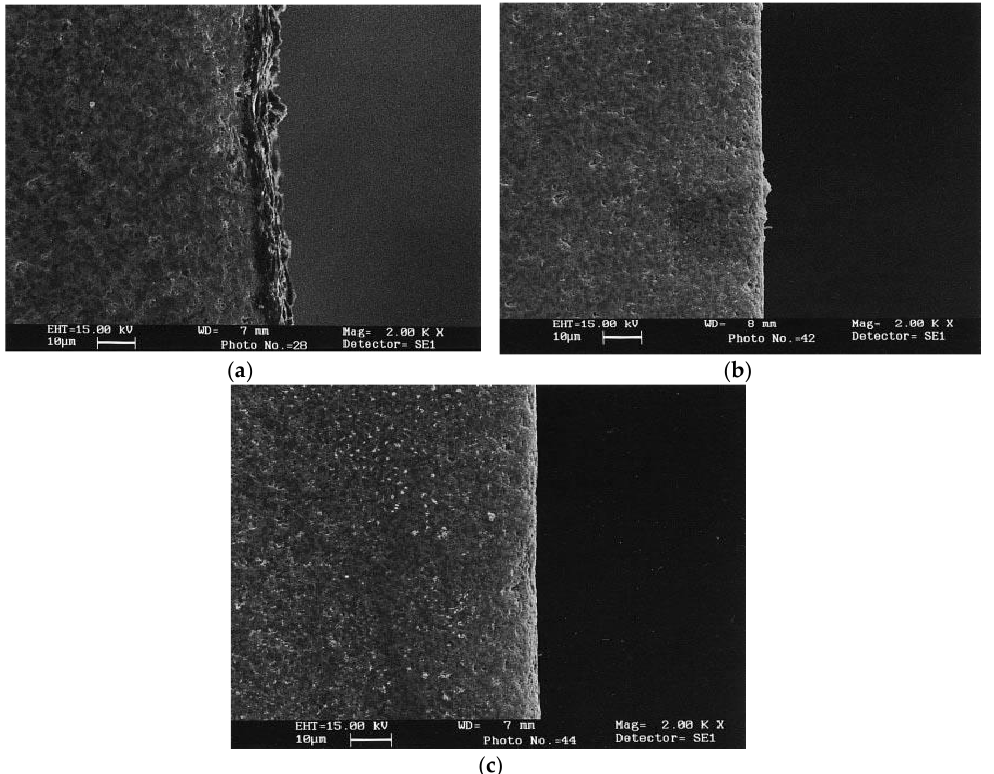
Figure 12. Cross-sectional scanning electron microscope (SEM) micrographs of EDM and treated surfaces of Al 2 O 3 /TiC ceramic composite ( a ) EDM; ( b ) treated by abrasive blasting; ( c ) treated by ultrasonic machining. (Reproduced with permission from [107]).